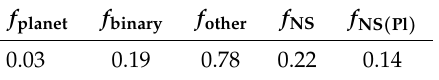
Table 1. The resulting PN progenitor population proportions when adopting the probabilities of engulfment according to the known exoplanets evolved with stellar models according to the measured metallicity of each host star. The planet and binary fractions of PN progenitors are denoted as f planet and f binary , respectively, while the fraction of PN progenitors which will evolve as single stars to form spherical PNe (i.e., single stars without a planet engulfment, and binary systems which do not interact) is denoted as f other . The predicted fraction of non-spherical PNe, f NS is 22%, of which 14% of the non-spherical population are expected to be the result of a planet engulfment ( f NS ( Pl )